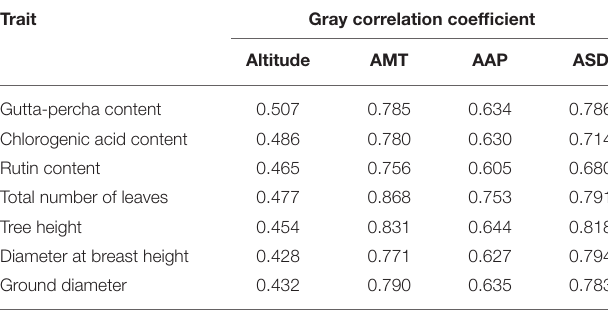
TABLE 7 | Gray correlation analysis among traits and environmental factors.